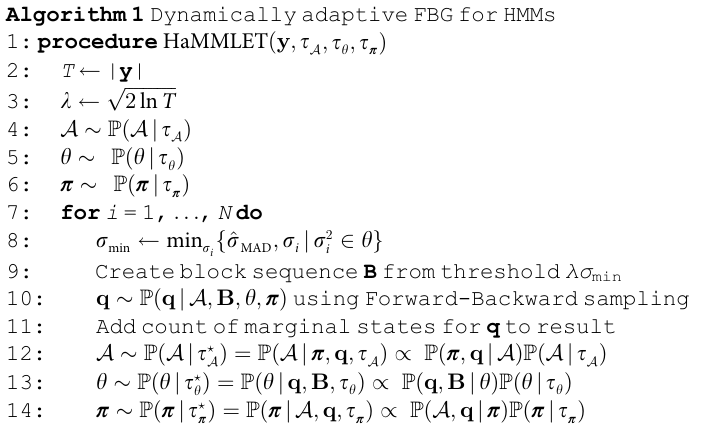
Algorithm 1 Dynamically adaptive FBG for